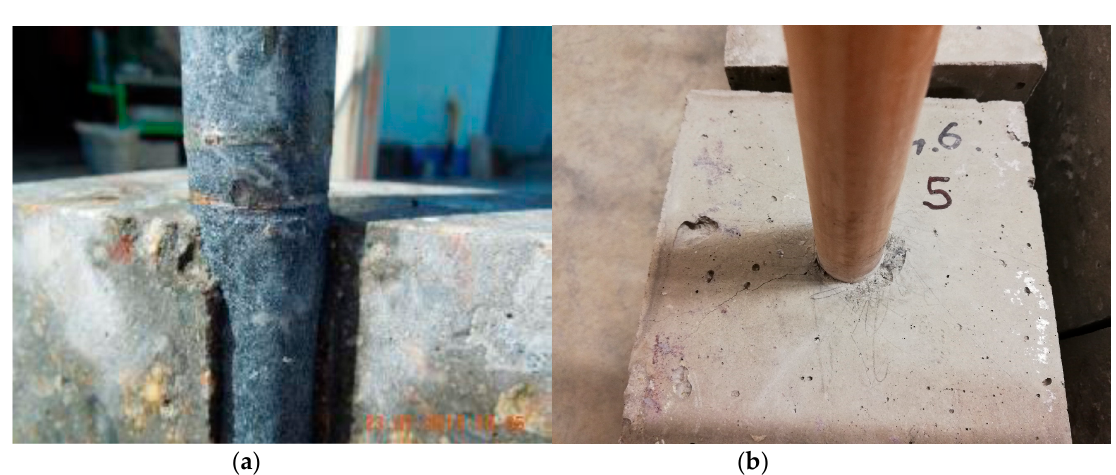
Figure 8. Beam after longitudinal displacement test: ( a ) damage of the PE plastic coating; ( b ) damage of concrete after testing (fiberglass dowel).